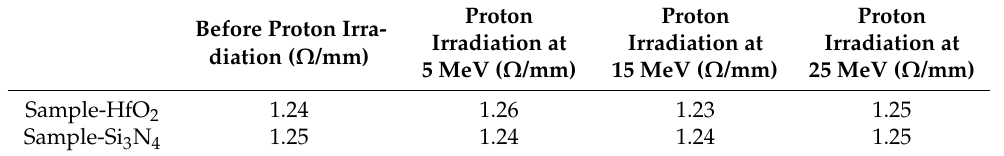
Table 2. Extracted contact resistance before and after proton irradiation in GaN-based MIS-HEMTs for the 5 nm-thick HfO 2 and the Si 3 N 4 gate insulator. Proton Proton Proton Before Proton Irra- Irradiation at Irradiation at Irradiation at diation ( Ω /mm) 5 MeV ( Ω /mm) 15 MeV ( Ω /mm) 25 MeV ( Ω /mm) Sample-HfO 2 1.24 1.26 1.23 1.25 Sample-Si 3 N 4 1.25 1.24 1.24